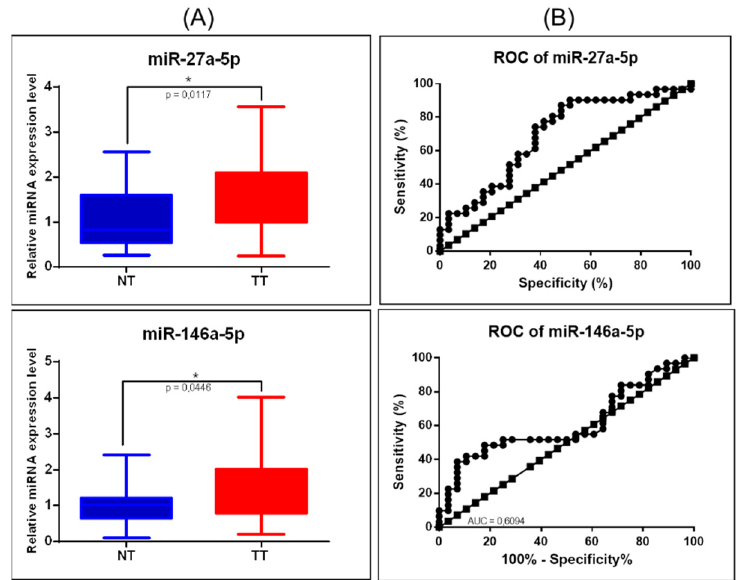
Figure 9. miRNA targeting key EMT signaling genes in COAD. ( A ) Scatter plots demonstrate the upregulation of miR-27a-5p and downregulation of miR-146a-5p in tumor tissues versus normal adjacent tissues; U6 and RNU48 were used as normalizations (* p ≤ 0.05); ( B ) ROC curve for miR-27a-5p and miR-146a-5p (NT: normal tissue, TT: tumoral tissue, ROC: receiver-operating characteristic, AUC: area under the curve).